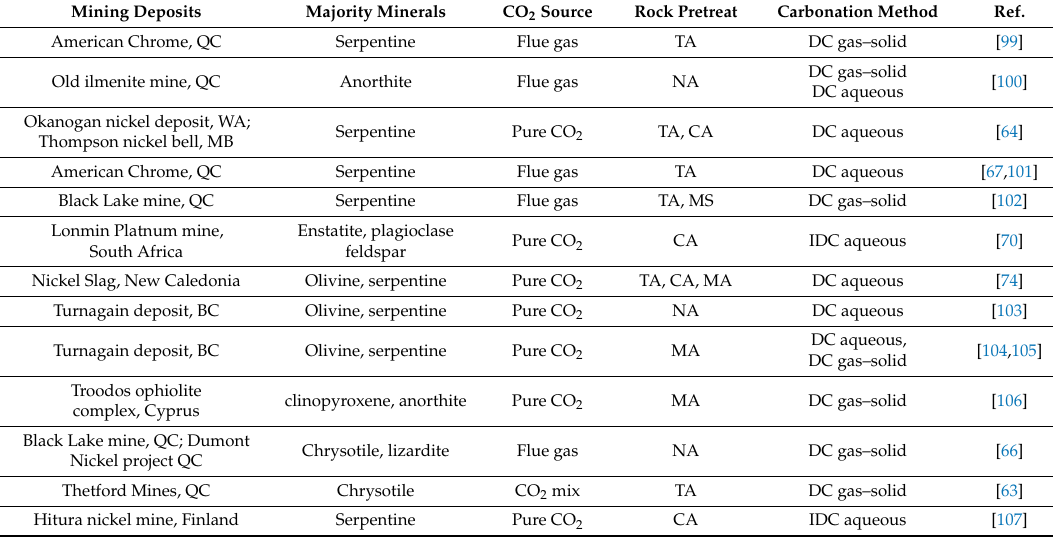
Table 1. Summary of current studies on ex-situ mineral carbonation of mine waste